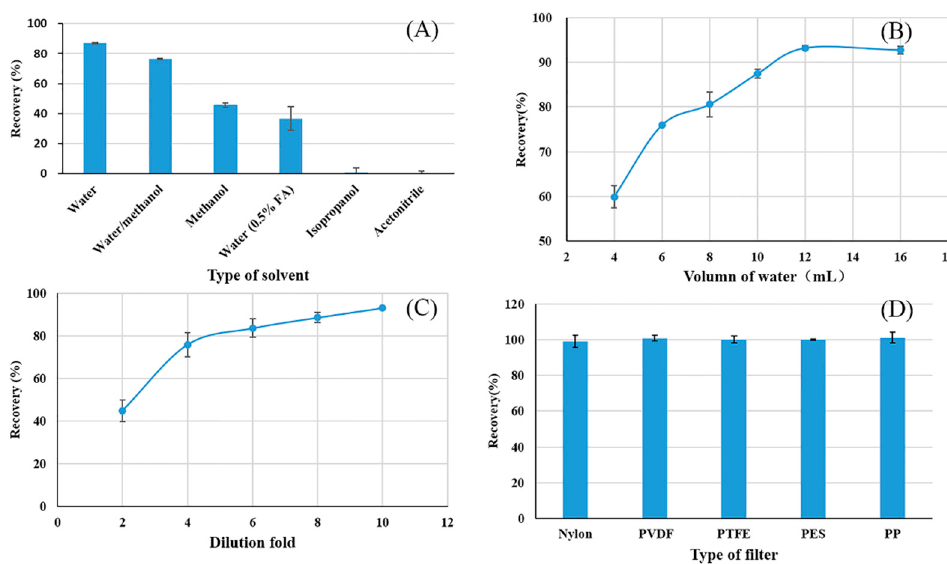
Figure 1. Optimization of the ( A ) type and ( B ) volume of extraction solvent; ( C ) effect of dilution fold; ( D ) type of filter (n = 3).